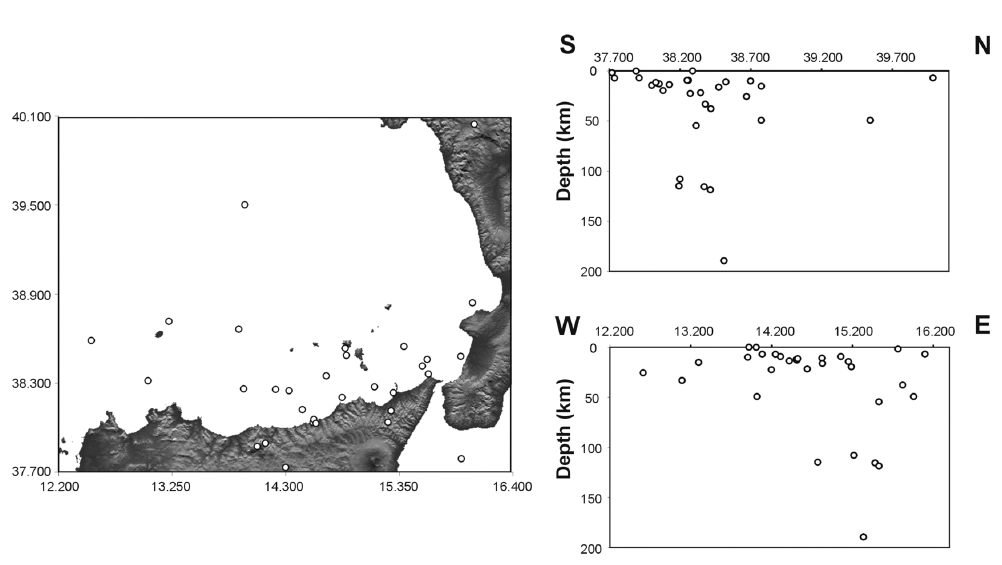
Fig. 7. Integrated locations of new events. Locations of the events and S-N and W-E sections are presented on left and right sides,